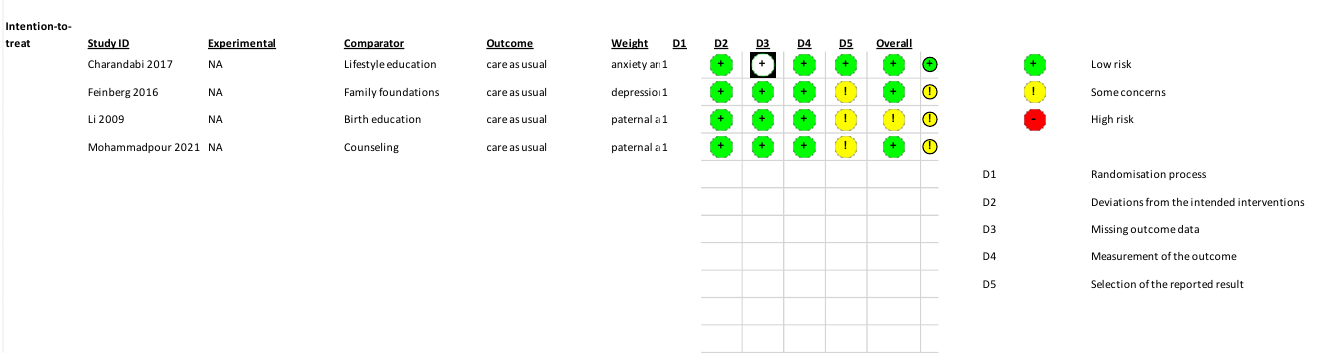
Figure 5. Risk of Bias assessments – trait anxiety outcomes [38,41,43,46].